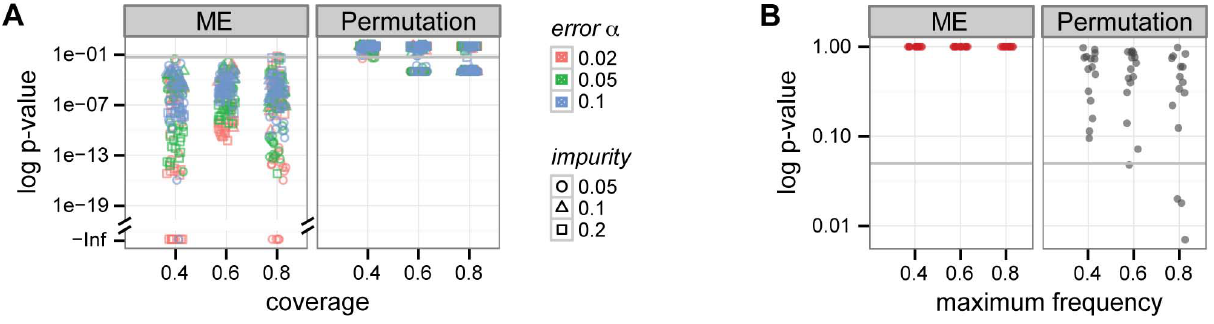
Figure 5. Power of the mutual exclusivity model accounting for false positives. The ME test p-values for A data generated from the full mutual exclusivity model with b ~ 0 given, and B generated from the independence model, in comparison to a permutation test applied in previous studies. Again, the ME test is more powerful (compare Figure 2).